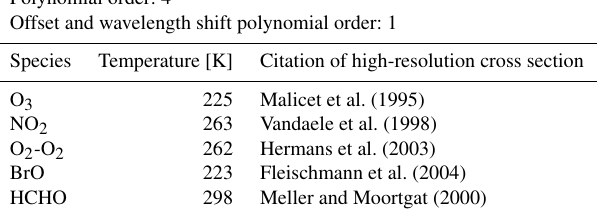
Table 1. DOAS fitting parameters used to calculate HCHO (cid:49) SCD from Pandora direct-sun measurements. Fitting wavelength window: 332–359nm Polynomial order: